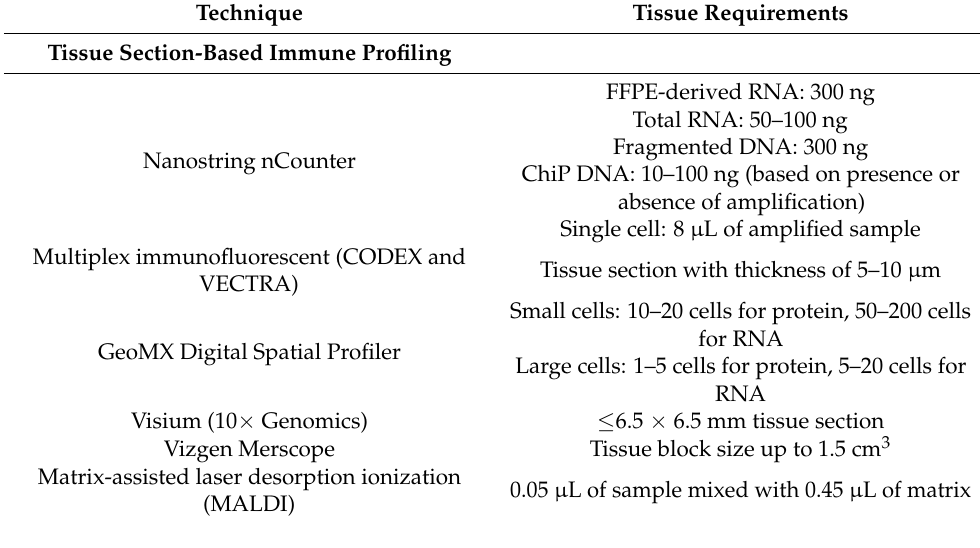
Table 2. Tissue and preparation requirements for different